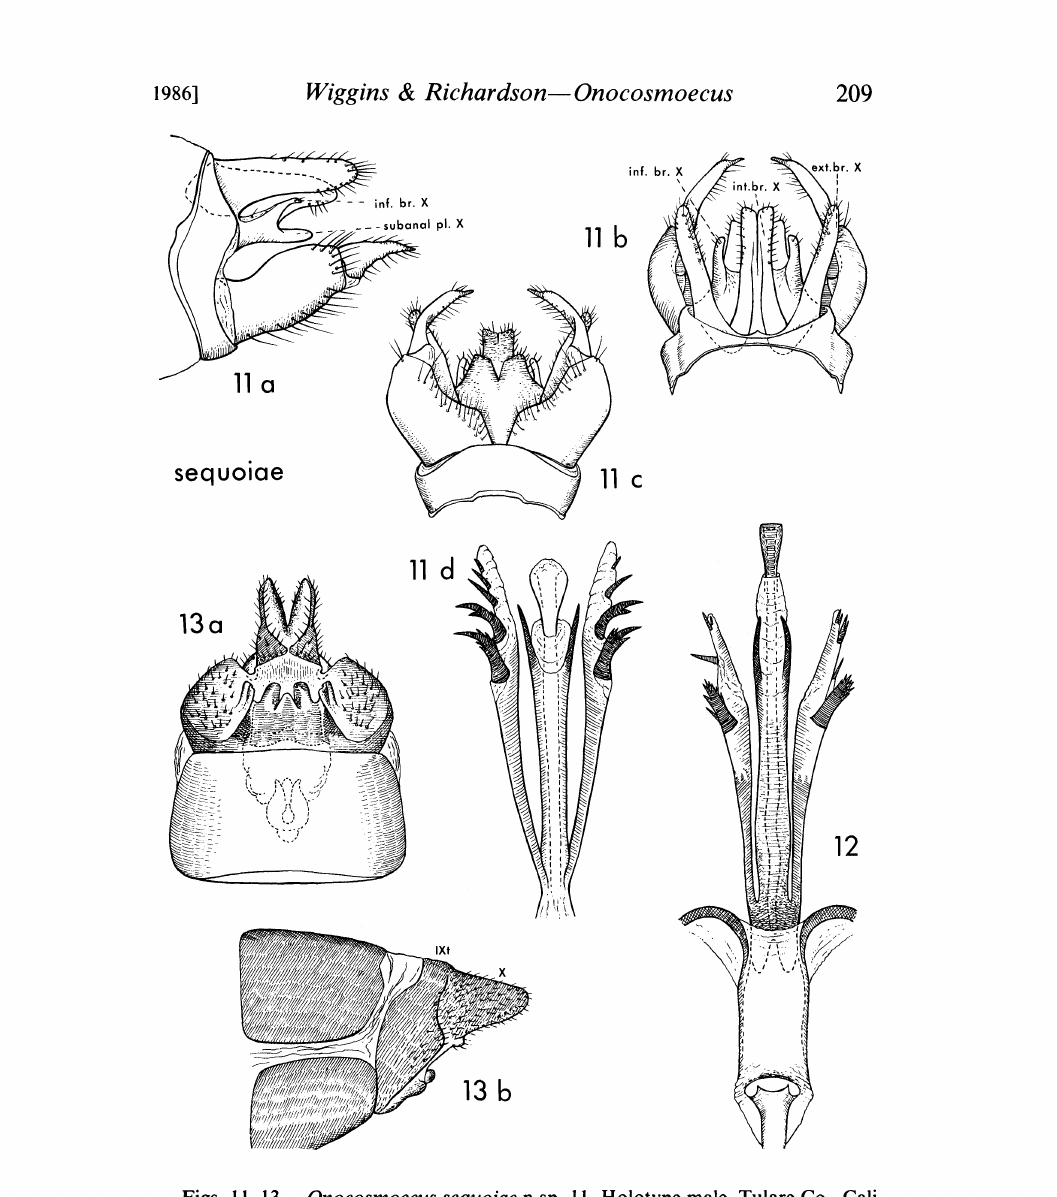
Figs. 11-13. Onocosmoecus sequoiae n.sp. I, Holotype male, Tulare Co., Cali- fornia, genitalia: a, lateral; b, dorsal; c, ventral; d, phallus. 12, Variant male, Shasta Co., California, phallus. 13, Allotype female, Tulare Co., California, genitalia: a, ventral; b, lateral. (ext. br. X, int. br. X., inf. br. X, external, internal, & inferior branches of segment X; subanal pl. X, subanal plate of segment X; IXt, tergum of segment IX; X, segment